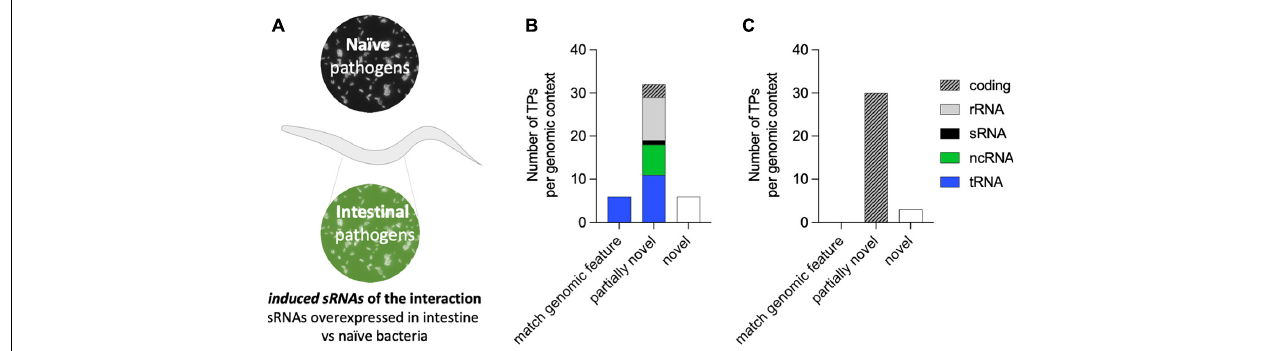
FIGURE 3 | (A) Diagram of the concept of bacterial-induced small RNAs (sRNAs). Induced sRNAs are those bacterial transcripts showing upregulation in all intestinal conditions (F1, F2, F5, and F6) compared to their expression in naïve bacteria. (B,C) RNA biotypes and genomic contexts of the induced bacterial sRNA (B) and constitutively expressed sRNAs (C) from P. aeruginosa . The genomic context category of matching genomic feature refers to transcripts that fit the size and genomic coordinate of an existing feature, and the category partially novel refers to transcripts that are either nested or overlapping a previously annotated genomic feature. The category novel refers to a transcript matching an intergenic region of the